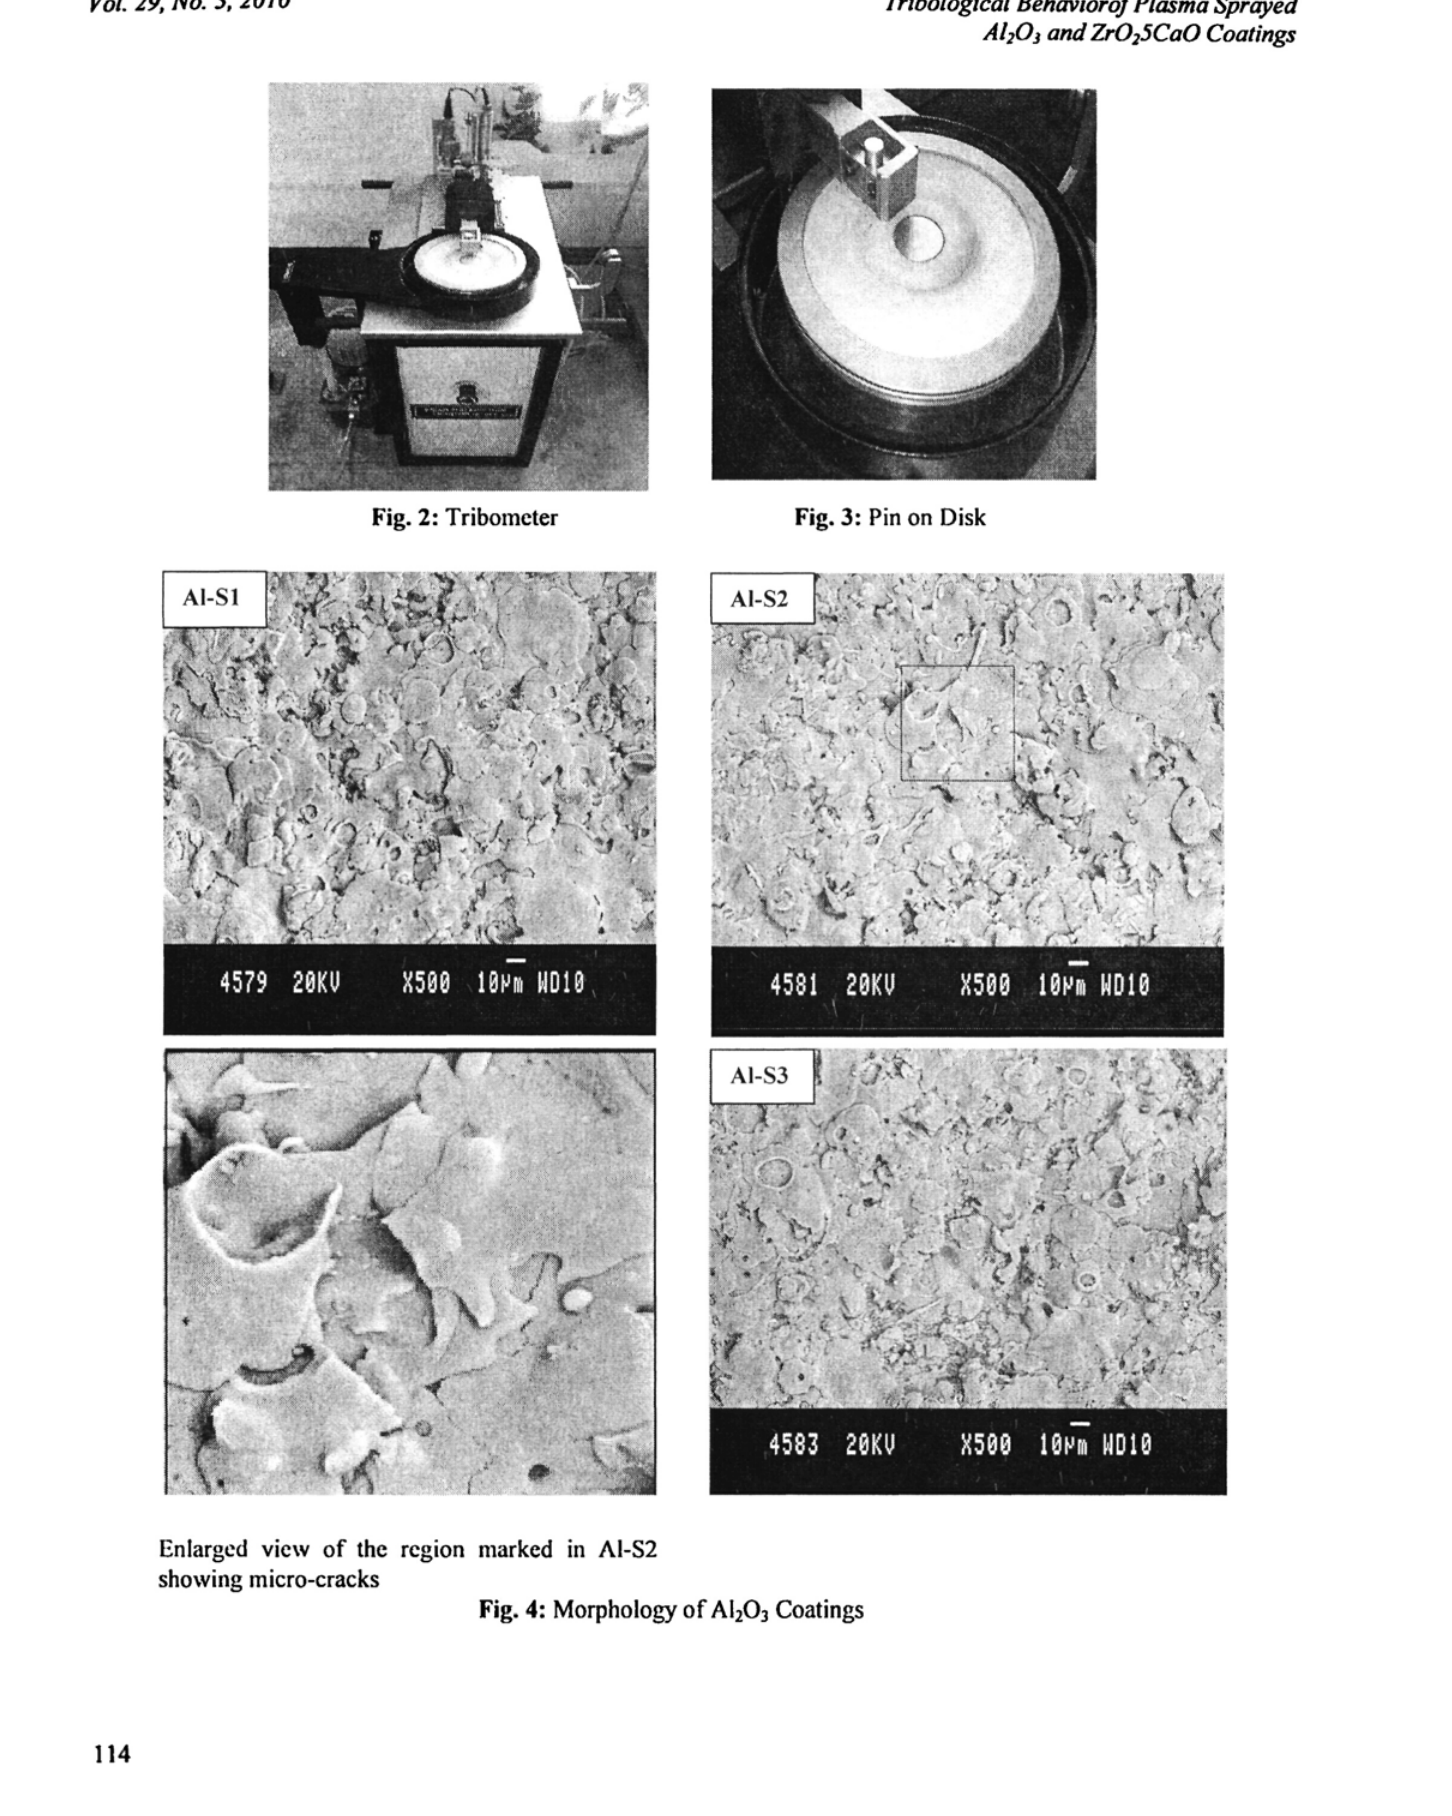
Fig. 4: Morphology of AI 2 O 3